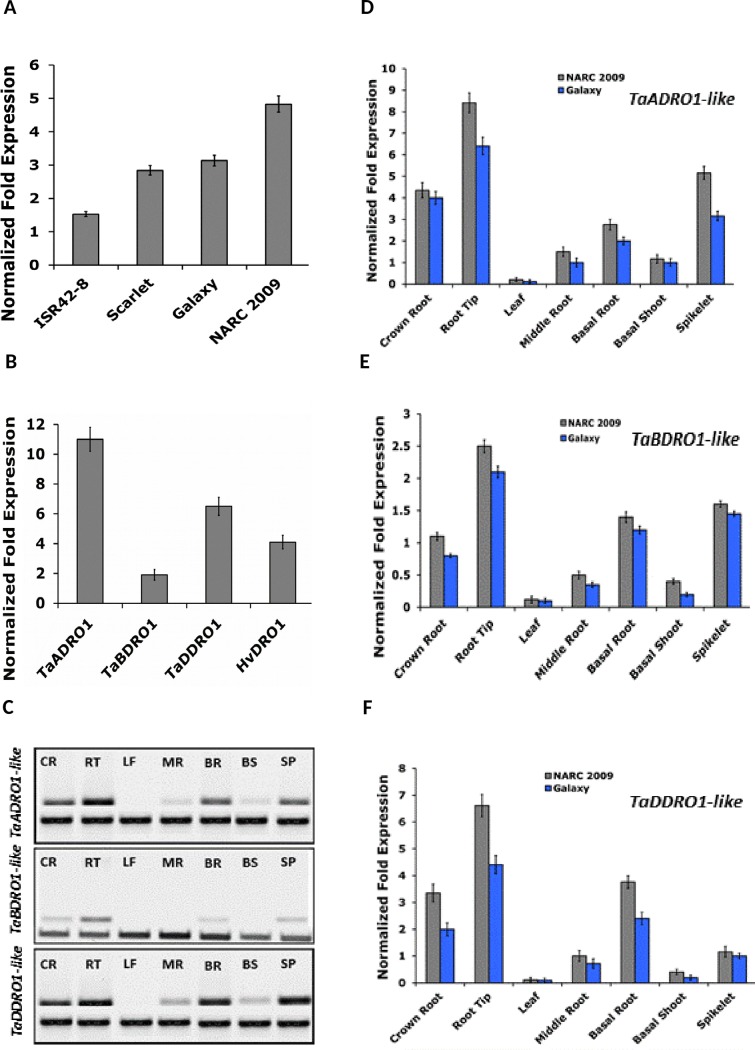
Gene expression patterns of DRO1-like transcripts in wheat and barley.(A) Quantitative real-time RT-PCR results of the HvDRO1-like and TaBDRO1-like transcripts in barley and wheat were performed. Normalized fold expression was generated using t elf as the internal control. Error bars indicate the standard deviation. (B) Comparison of normalized fold expression of four DRO1-like orthologs including TaADRO1-like, TaBDRO1-like, TaDDRO1-like of wheat and HvDRO1-like of barely. The tubulin and elf served as endogenous controls for normalized fold expression. (C) Semi-quantitative RT-PCR of DRO1-like transcripts of TaADRO1-like, TaBDRO1-like and TaDDRO1-like in different tissues of NARC 2009. The tubulin served as an internal control. CR, crown root; RT, root tip; LF, leaf; MR, middle root; BR, basal root; BS, basal root; SP, spikelet. (DEF) Quantitative real-time RT-PCR of DRO1-like transcripts of TaADRO1-like
(D), TaBDRO1-like
(E) and TaDDRO1-like
(F) in different tissues of NARC 2009 and Galaxy cultivars of wheat. The tubulin and elf served as endogenous control for normalized fold expression. Color legend is given. Error bars indicate the standard deviation.